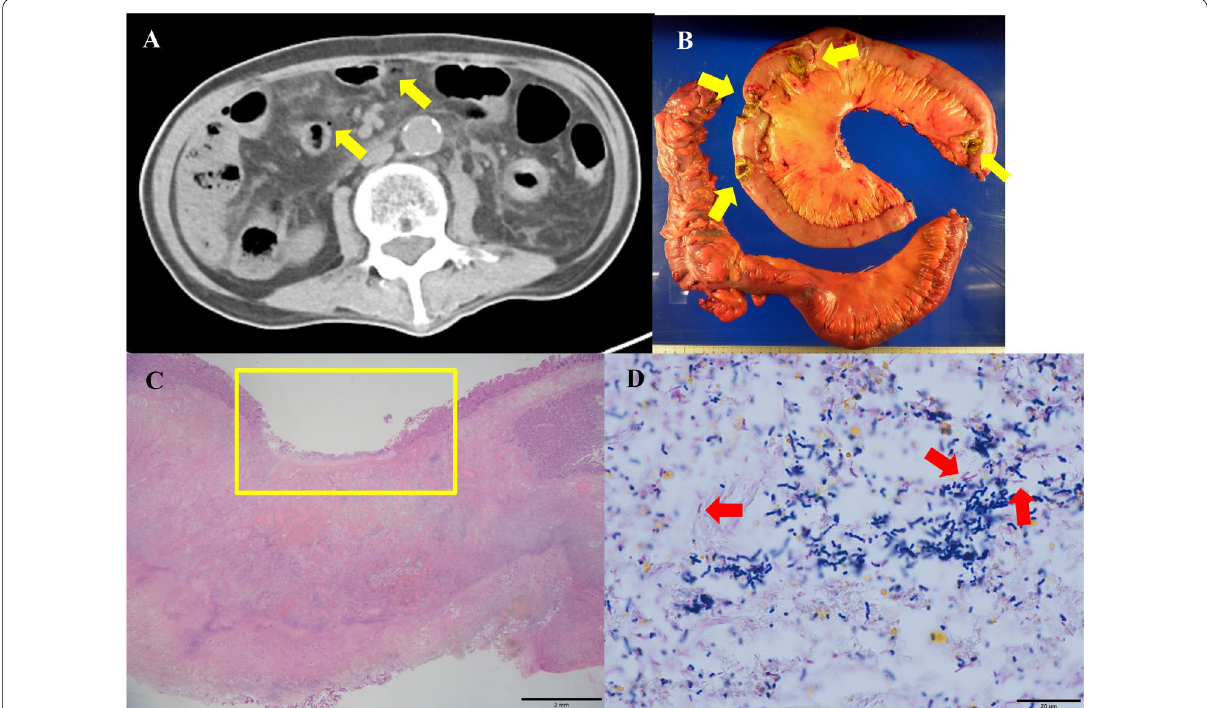
Fig. 1 A Plain abdominal computed tomography showing free air (yellow arrows) with a small amount of effusion to the surrounding edematous small intestine. B Macroscopic image of the resected specimen. Bowel perforations with patchy necrotic lesions (yellow arrows) are shown. C Hematoxylin–eosin stain of histopathologic image showing ulcer (yellow enclosing line) of ileum. D Gram stain showing proliferation of Gram-negative rods (red arrows) with Gram-positive rods and cocci near the perforated